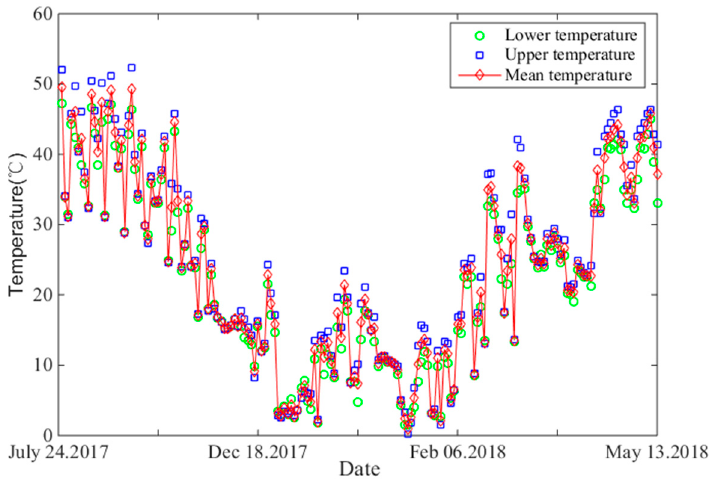
Figure 4. Temperature variations of RC slab.